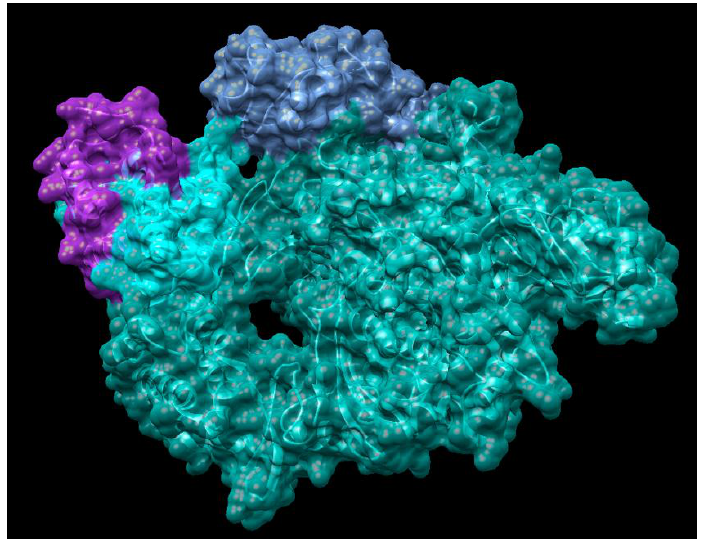
Figure 3. Structure of SARS-Coronavirus RNA polymerase NSP12 complex with NSP7 and NSP8 co- factors (PDB: 6NUR). Chain A is highlighted in light sea green, chain B is shown as blue, chain C is highlighted in cyan, chain D is highlighted in purple.